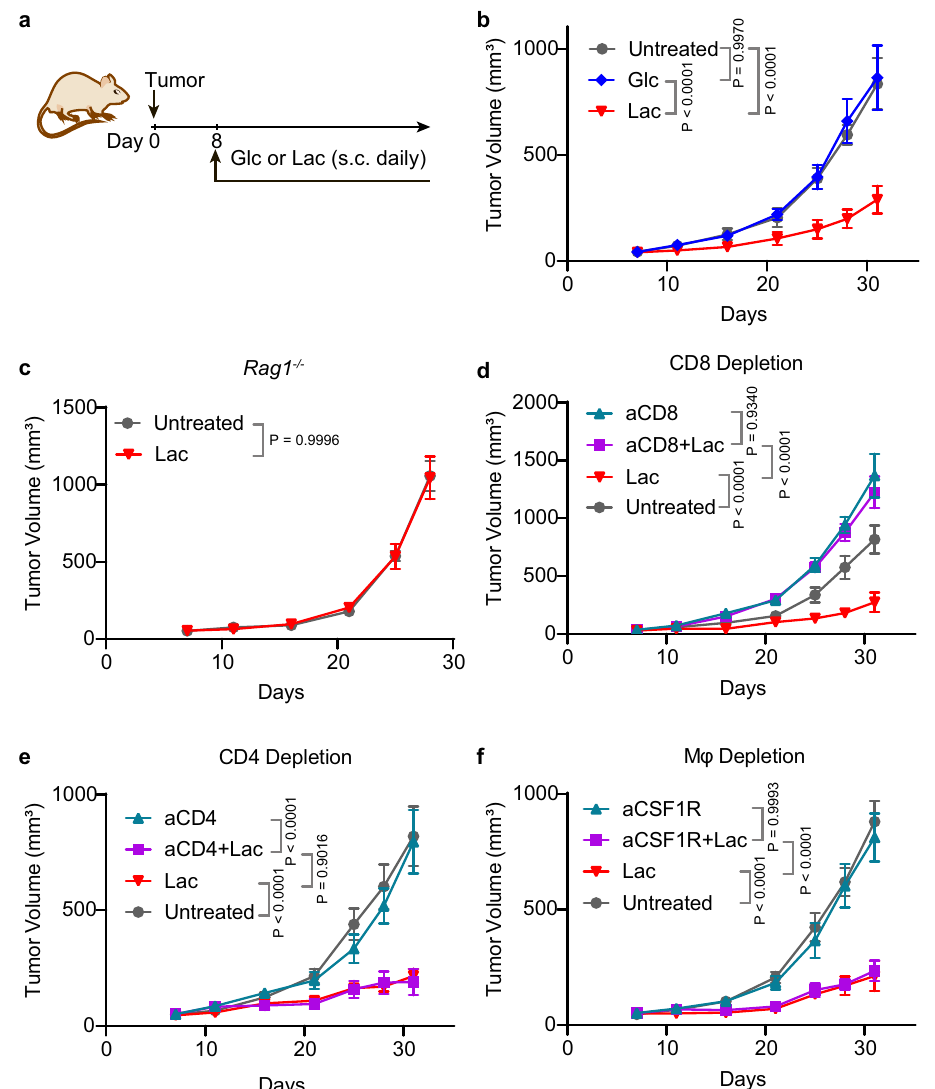
Fig. 1 | Lactate augments antitumor immunity through CD8 + T cells. a Treatment regimen for glucose (Glc) or lactate (Lac). Glucose (5g/kg) or lactate (1.68g/kg) was subcutaneously administrated daily from Day 8 after tumor inoculation. b Tumor growth curve of MC38 tumor model treated with glucose or lactate. C57BL/6 mice ( n =6) were inoculated with 1×10 6 MC38 tumor cells and treatedwithglucoseorlactate. c ,TumorgrowthcurvesofMC38tumorinB6.129S7- Rag1 tm1Mom ( Rag1 − / − ) mice treated with lactate. Rag1 − / − mice ( n =7) were inoculated with 1×10 6 MC38 tumor cells and treated with lactate. CD8 + T cell ( d ), CD4 + T cell